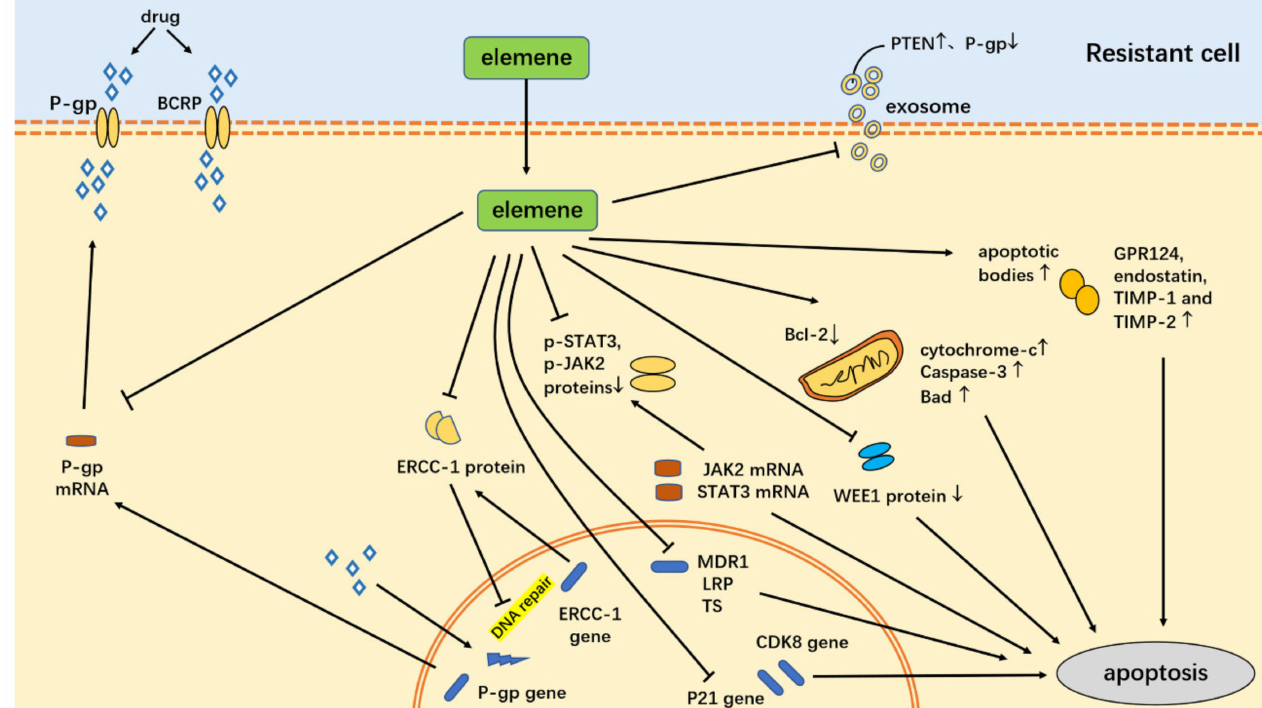
Figure 6. Pathways of elemene reversing drug resistance through the apoptotic pathway. The symble ↑ indicates upregulated expression. The symble ↓ indicates downregulated